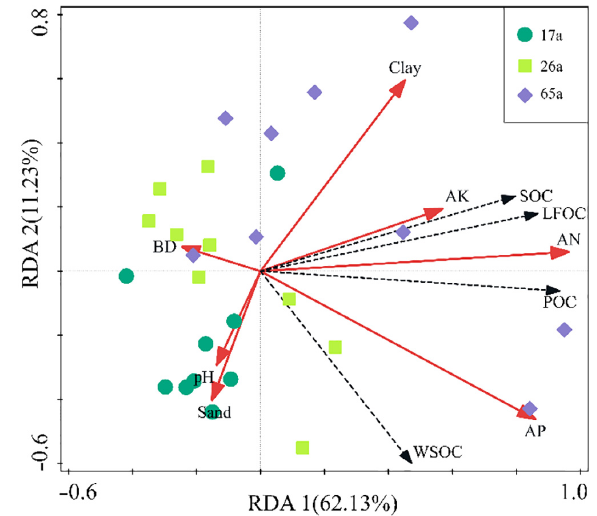
Figure 5. Redundancy analysis screening of soil physicochemical properties (red arrows) affecting the soil carbon fraction (black arrows). SOC, soil organic carbon; POC, particulate organic carbon; WSOC, soil water-soluble organic carbon; LFOC, light fraction organic carbon; BD, bulk density; AN, alkaline hydrolysis nitrogen; AP, available phosphorus; AK, available potassium; 17a, 17-year-old stand; 26a, 26-year-old stand; 65a, 65-year-old stand.